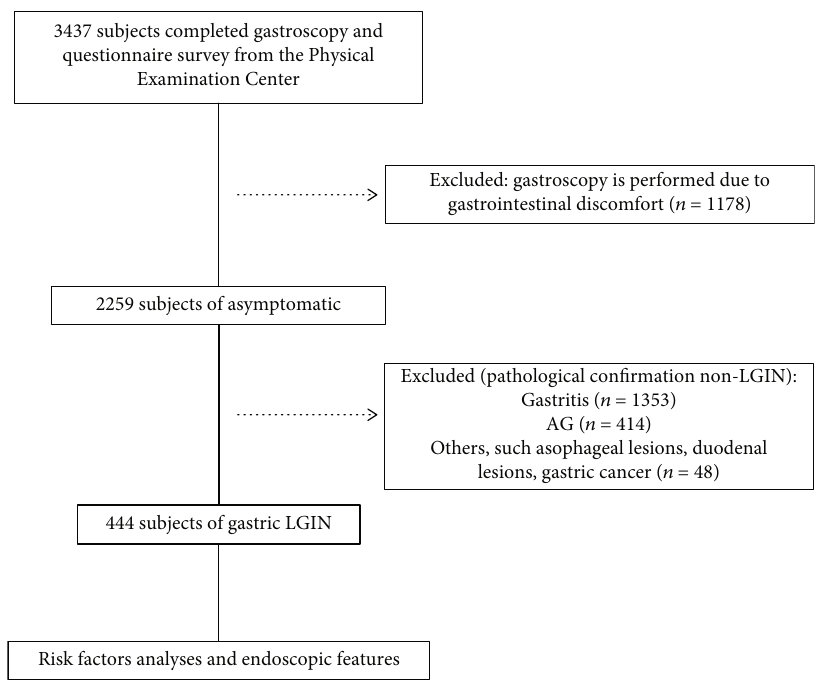
Figure 1: Flow chart for selecting the research population. Table 1: General characteristics in the asymptomatic and symptomatic